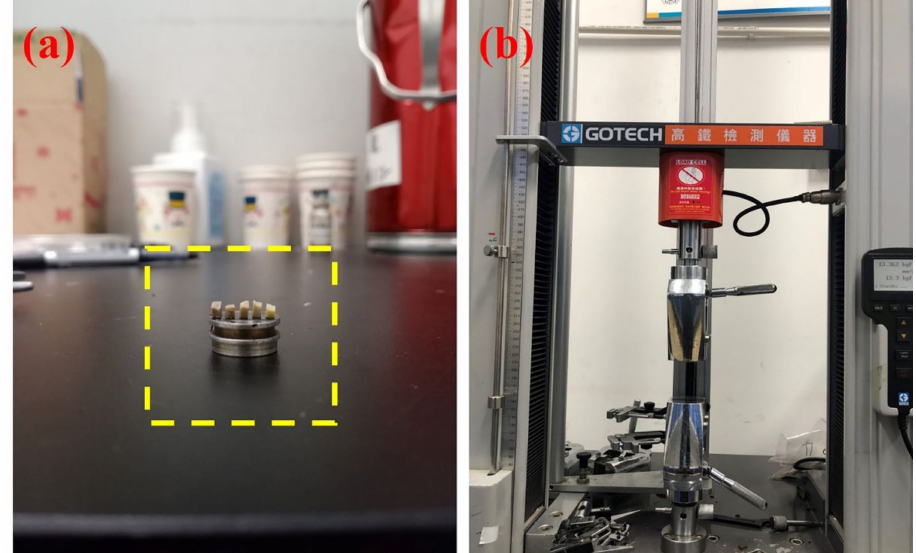
Figure 2. ( a ) the prepared MPU/EUG specimens for SEM observation; ( b ) mechanical property testing instrument used in this